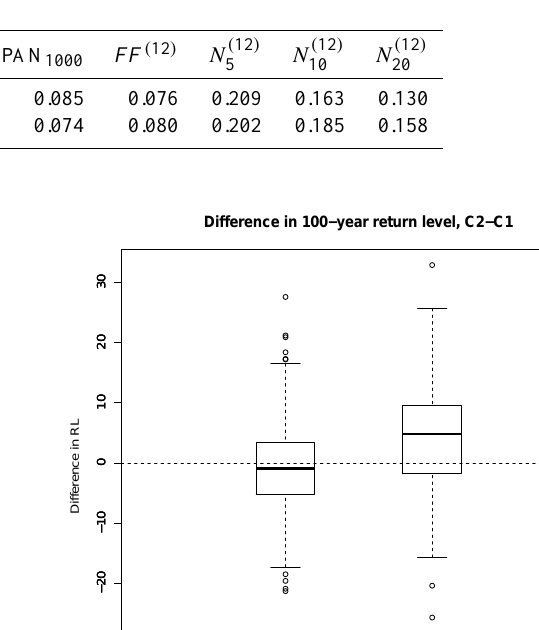
Table 1. Scores of evaluation for the local and regional definition of the seasons. Better scores have values closer to 0. Scores of SPAN T , for T = 20 , 100 and 1000 years, are the mean scores of (Eq. 9), while scores of FF and N T , T = 5 , 10 and 20 years, are based on the density areas (Eq. 10).